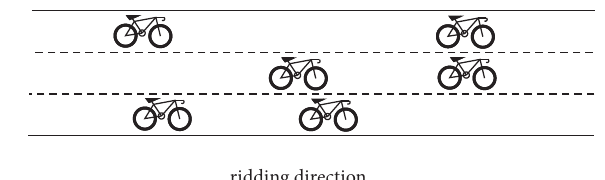
Figure 2: The simulation scenario of a three-lane circuit road, where the bicycle may have two kinds of group